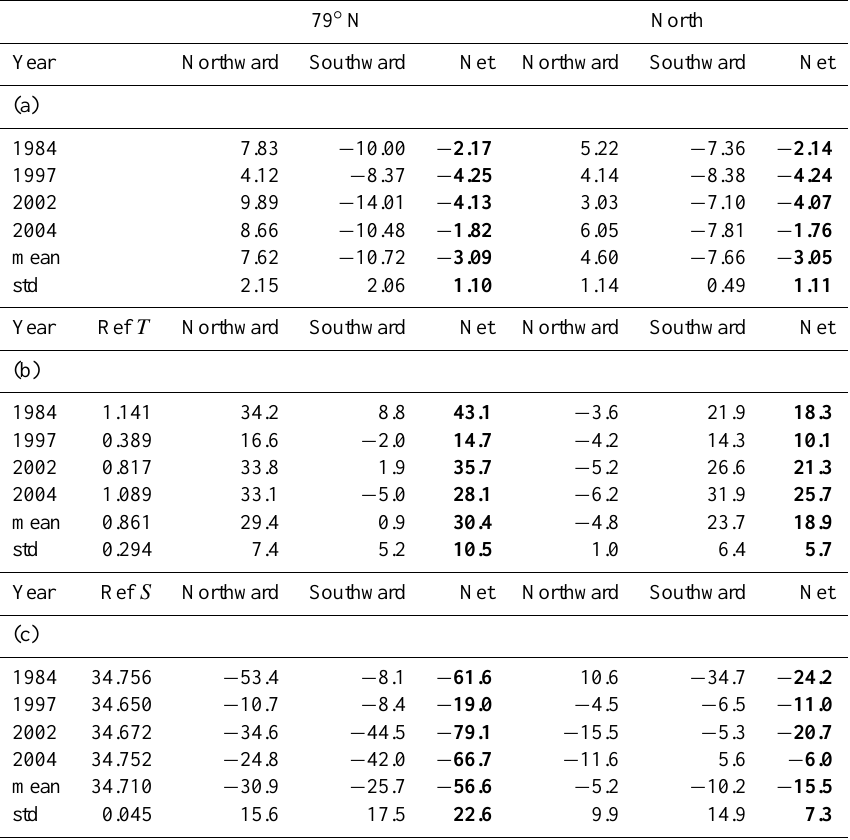
Table 2. Transports from zonal sections through the 79 ◦ N and the northern sections with constraints applied. Positive (negative) net transports are northward (southward). (a) Volume transports (Sv), (b) Heat/temperature transports (TW) relative to a varying reference temperature. Note that northward (southward) transports are negative (positive) when the transport has temperature < reference temperature (c) Freshwater transports (mSv) relative to a varying reference salinity. Northward (southward) transports are negative (positive) when the transport has salinity < reference